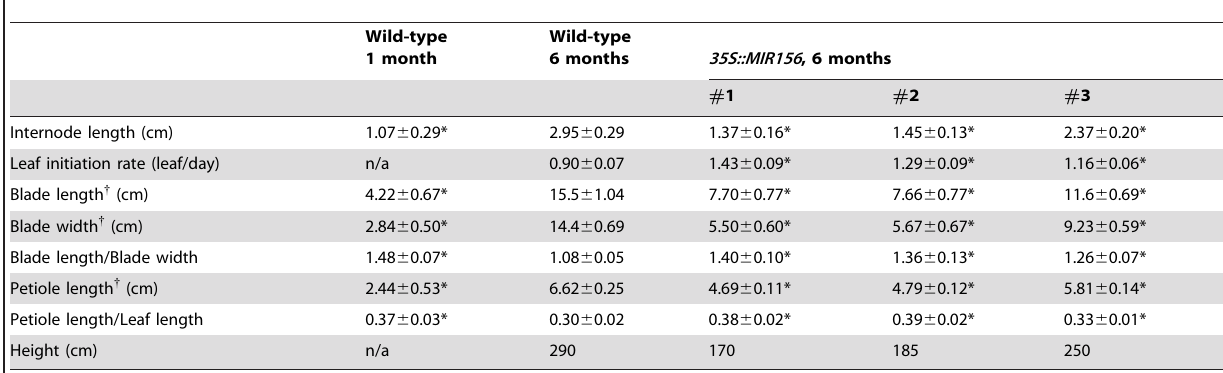
Table 1. Growth characteristics of 35S::MIR156 P. x canadensis